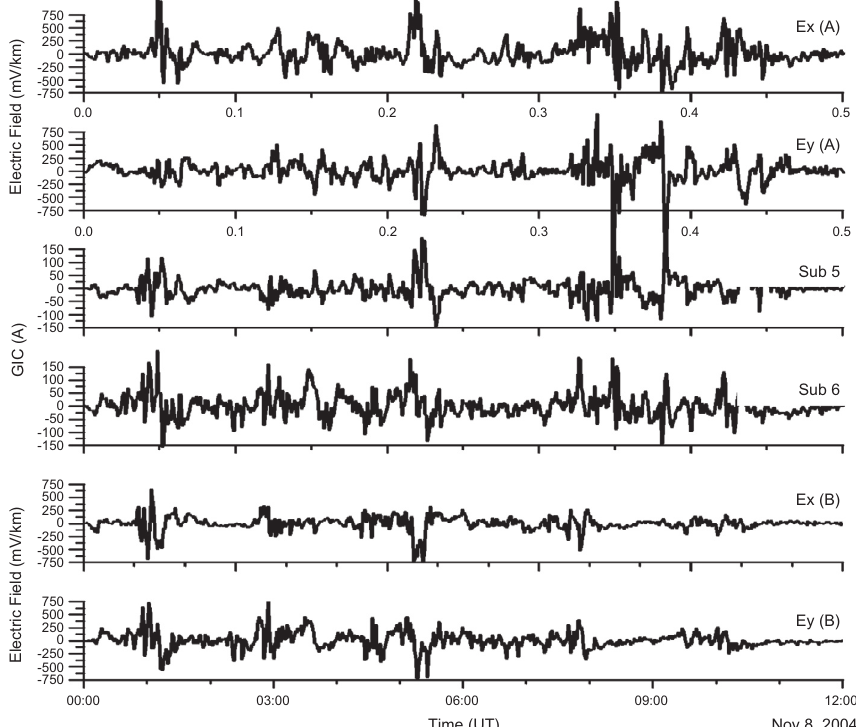
Fig. 10. Calculations made using the Nodal Admittance Matrix method and superposition (Eq. (38)) of results for electric field components E X and E Y calculated using data from the Poste de la Baleine magnetic observatory (A) to the North and the Ottawa magnetic observatory (B) to the South to give the GIC at substations 5 and 6 in the sample network of Figure